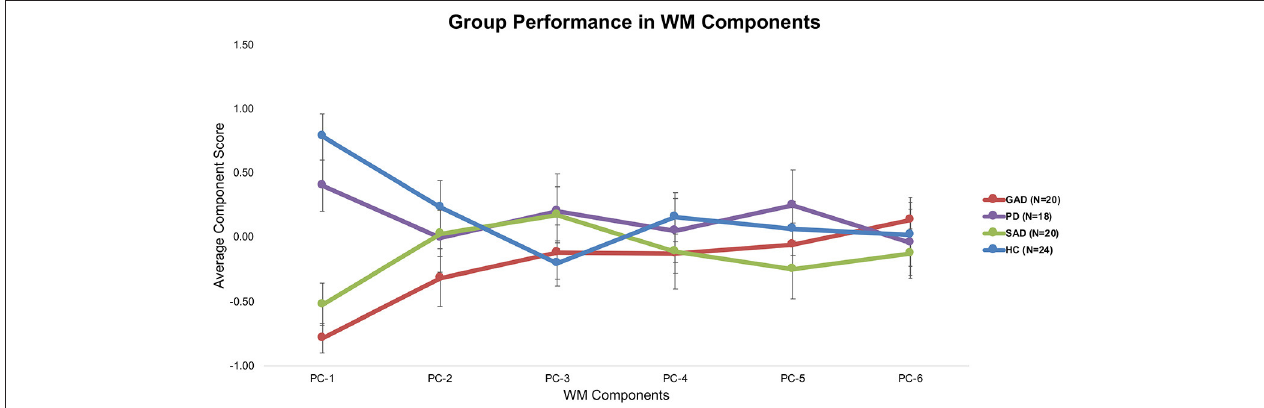
FIGURE 3 | Average performance of different groups on WM components ( ±